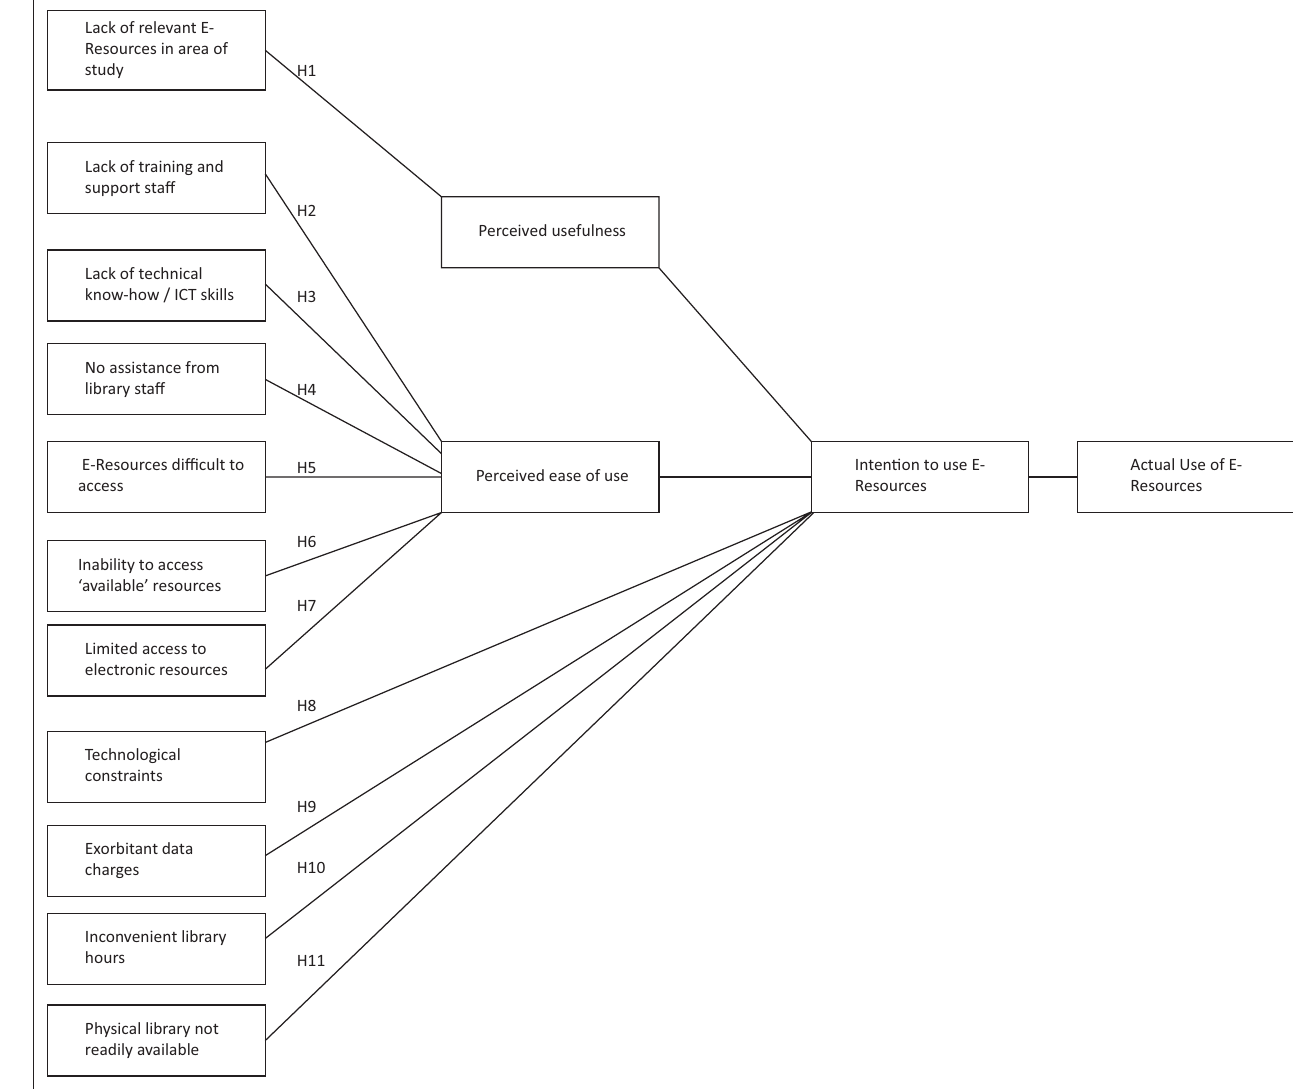
FIGURE 1: E-resource utilisation model derived from the Technology Acceptance